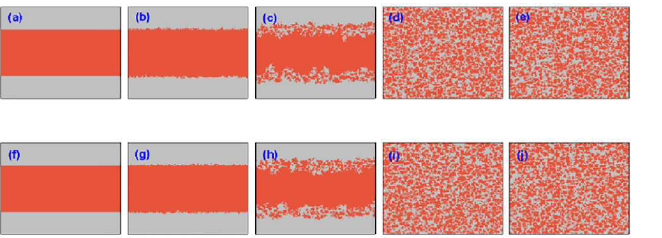
Fig 6. Characteristic snapshots of cooperators and defectors on two independent lattices for a fixed temptation to defect ( b = 1.07) starting from a prepared strategy distribution. In the upper row, from panel (a) to (e), snapshots are taken from one lattice at the time step 1, 10, 100, 1000, 50000,respectively; Similarly, in the lower row, we providethe snapshotson the other lattice at the same time step. The orange dots represent the cooperators, and the light gray dots denotethe defectors. The system setup is assumed to be L = 200, MCS = 5 × 10 4 and κ = 0.1 and the tunableparameter α = 0.8.